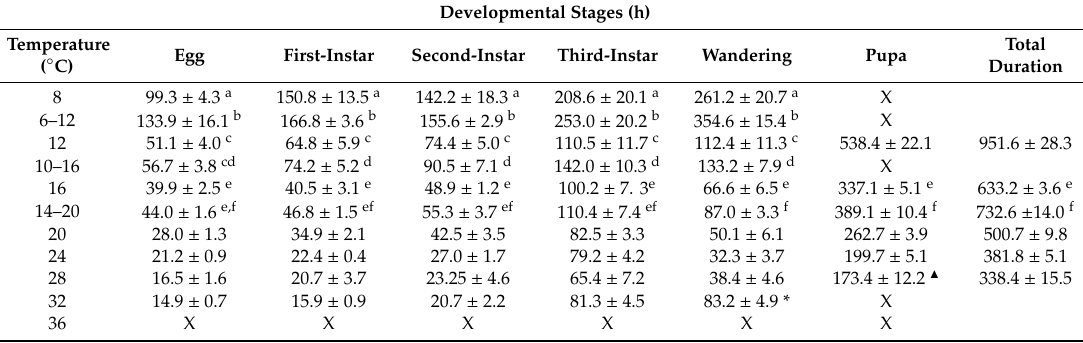
X represent failure enter the developmental stages. * represent the interval from wandering to larvae wizened and died in 32 °C. ▲ represents results where the eclosion rate was very low (<10%). a–f represent Values within the same column followed by the same letter do not differ significantly from each other based on a one-way ANOVA + LSD test at p < 0.05.